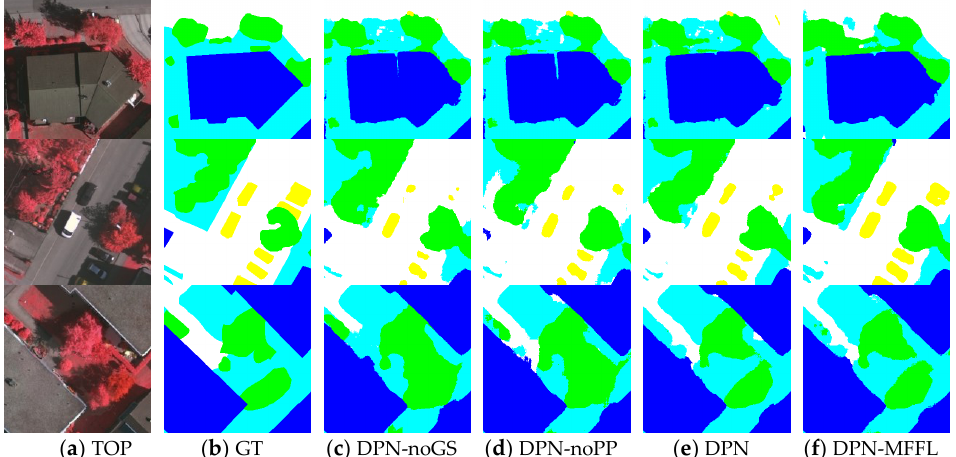
Figure 5. Semantic segmentation results for three image patches of Vaihingen validation set. The label includes six categories: impervious surface (imp surf, white); building (blue); low vegetation (low veg, cyan); tree (green); car (yellow); and clutter/background (red).